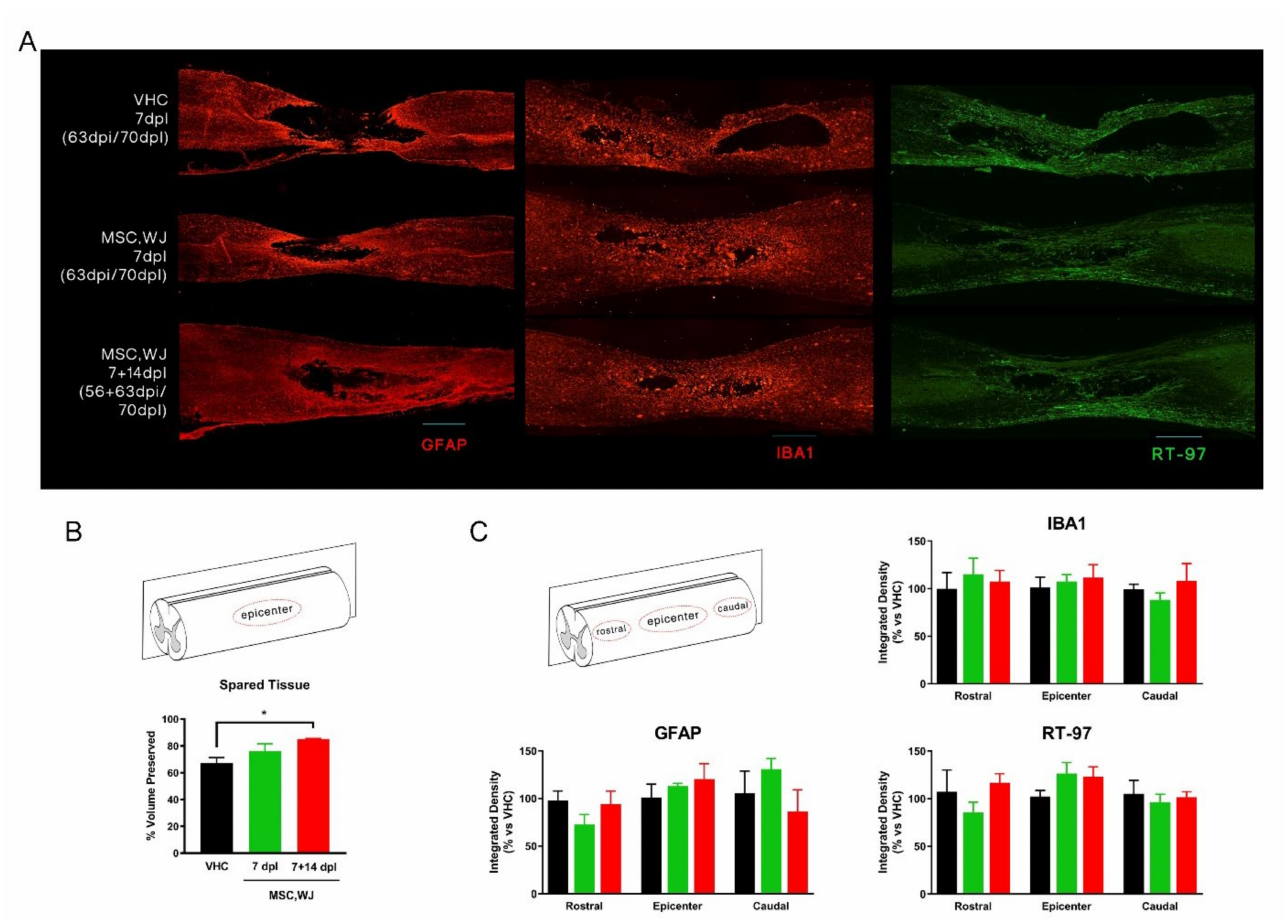
Figure 7. Histological studies. ( A ) Representative longitudinal images from each experimental condition. From left to right: Glial fibrillary acidic protein (GFAP) staining in red (marked astro- cytic reactivity around the lesion), Iba1 staining in red (immune cell recruited around the injury), and RT-97 staining in green (axonal pathways within the injured spinal cord). Bar scale: 100 µ m. ( B ) Scheme of measured areas in B. Quantification of estimated % volume of spared tissue. Significant increase of spared tissue was observed in MSC,WJ 7 + 14 dpl group vs. vehicle (VHC); * p < 0.05. ( C ) Scheme of measured areas in C. Measurements of immunolabeled density of microglia (Iba1), astroglial reactivity (GFAP) and axonal reactivity rostral, caudal and lesion site (epicenter) at 70 days post-lesion (dpl) did not reveal changes induced by MSC,WJ administration cells. Scale bar: 100 µ m. n = 5 in each